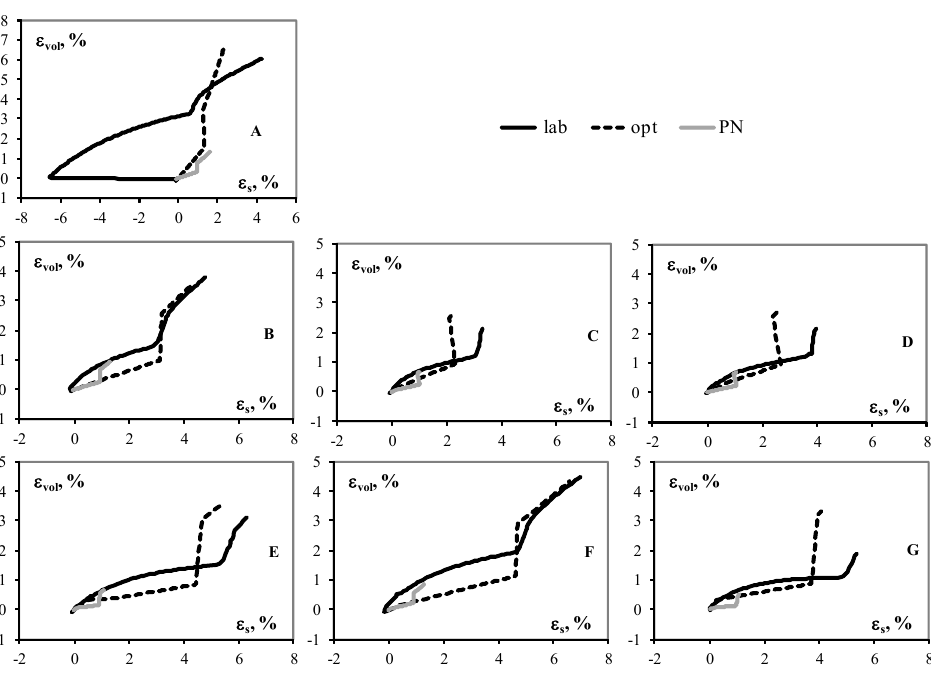
Fig. 4. Comparison of strain paths  s -  vol : experimental (lab), theoretical – optimal (opt) and theoretical – obtained on the basis of parameter values from Polish Standard